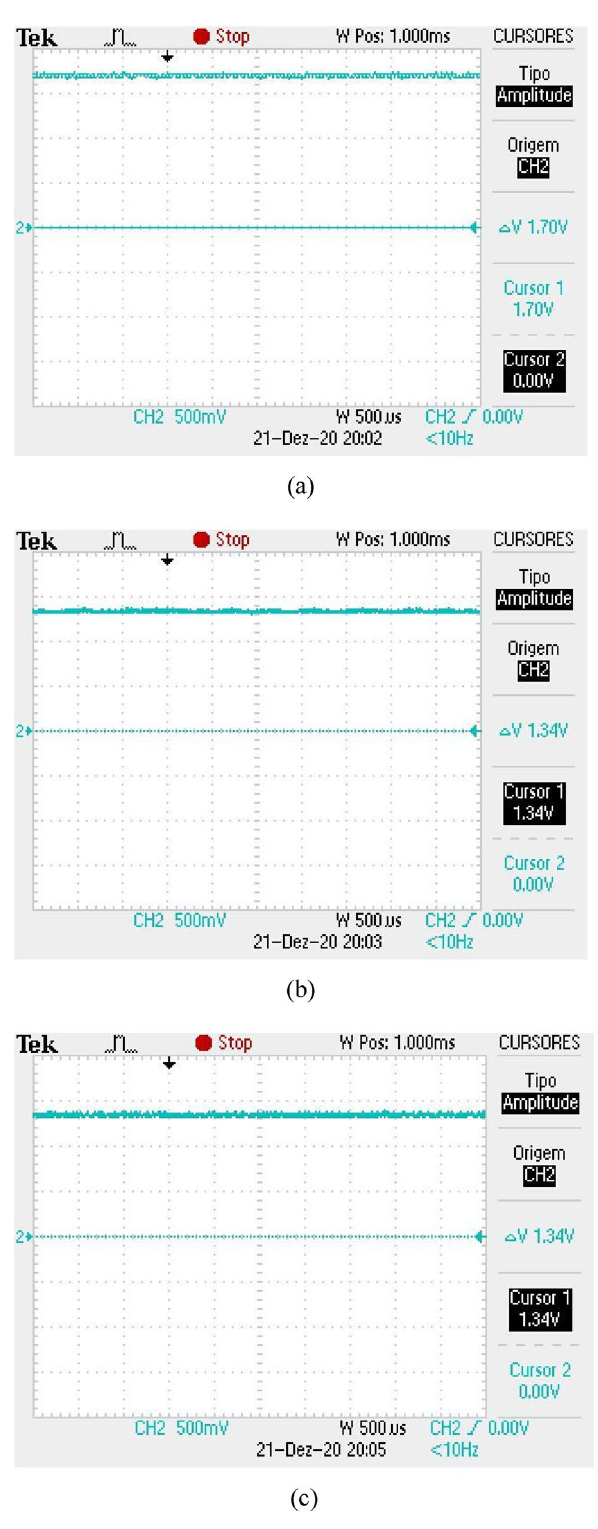
Figure 13. Reading of the DC level of the received signal for the second version of the Osseus : ( a ) without finger, ( b ) with finger in the correct decision and ( c ) with the finger in the rotated